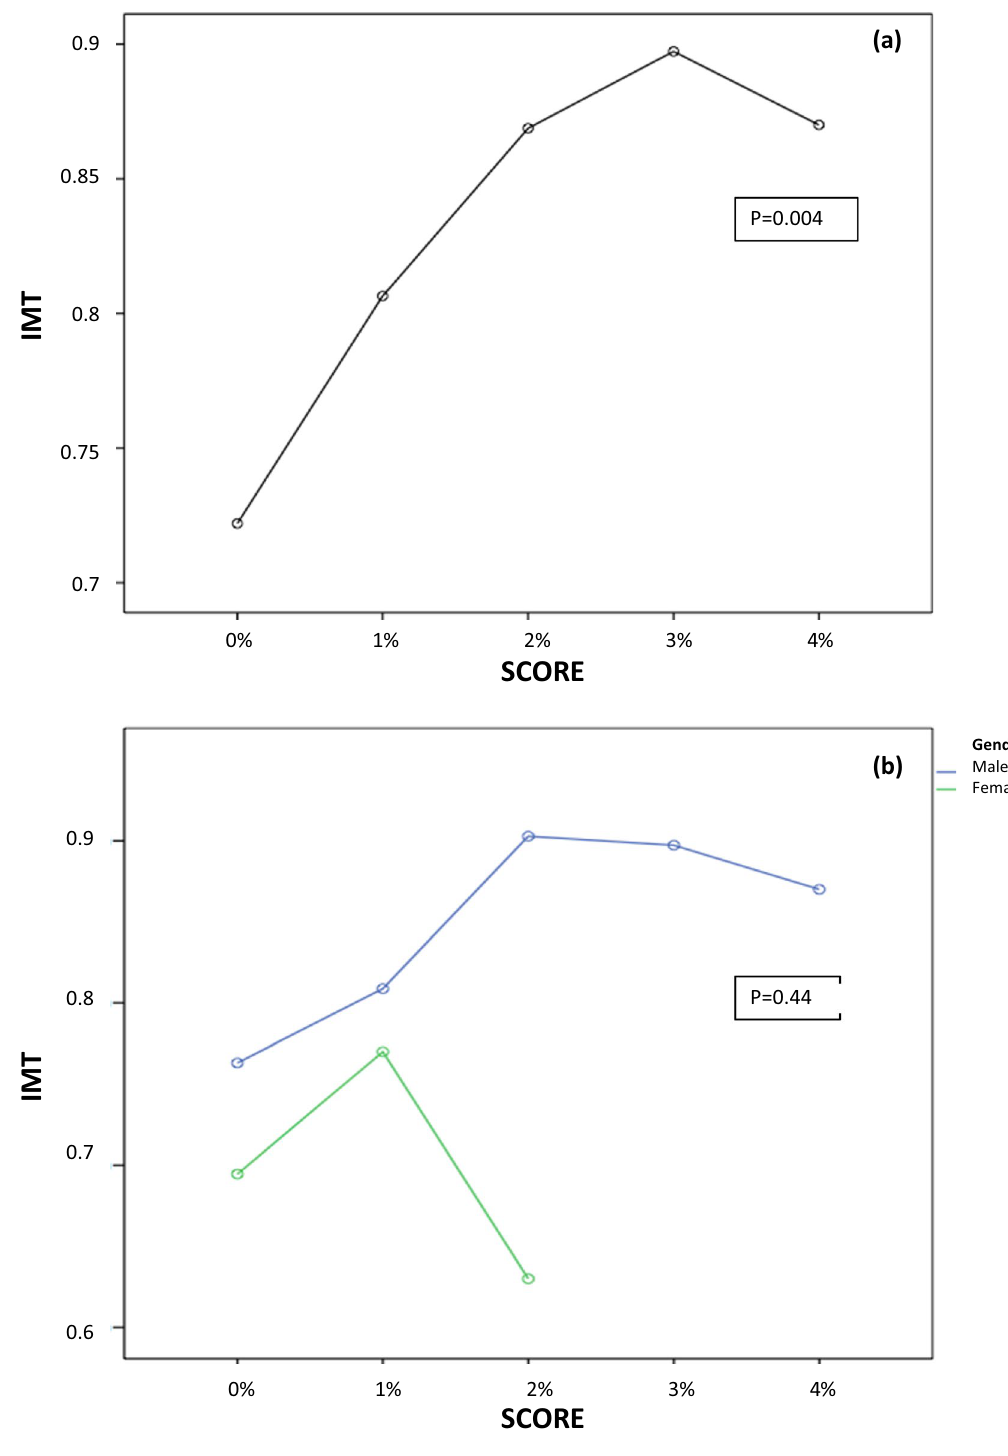
Figure 1. Asociation between IMT and SCORE. ( a ) Asociation between IMT and SCORE in the one-way ANOVA. ( b ) Asociation between IMT and SCORE and sex as independent factors in the two-way